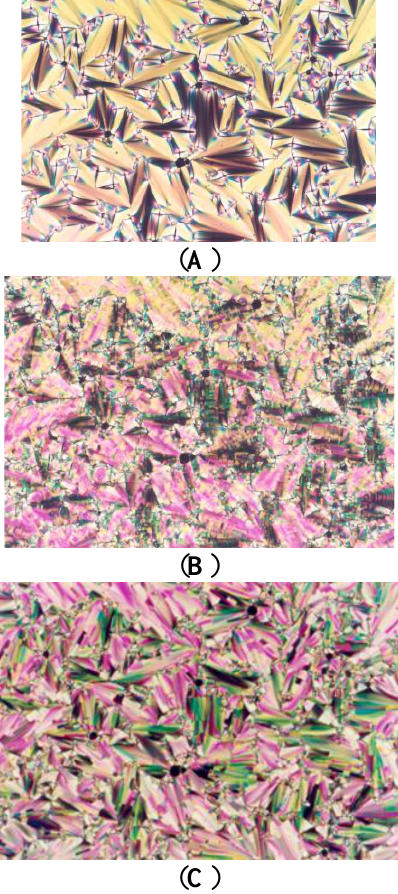
texture obtained after cooling to 140 °C. B